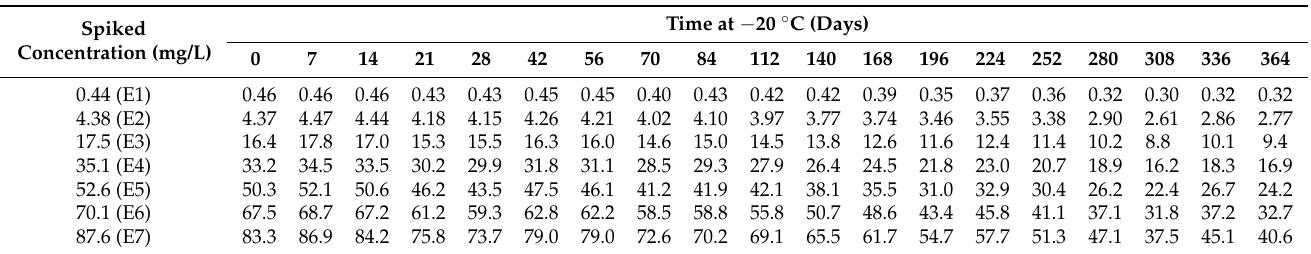
Table 1. Mean meropenem plasma concentrations for spiked plasma samples stored at − 20 ◦ C for different durations over 1 year ( n = 3 for each mean concentration reported). Spiked Concentration